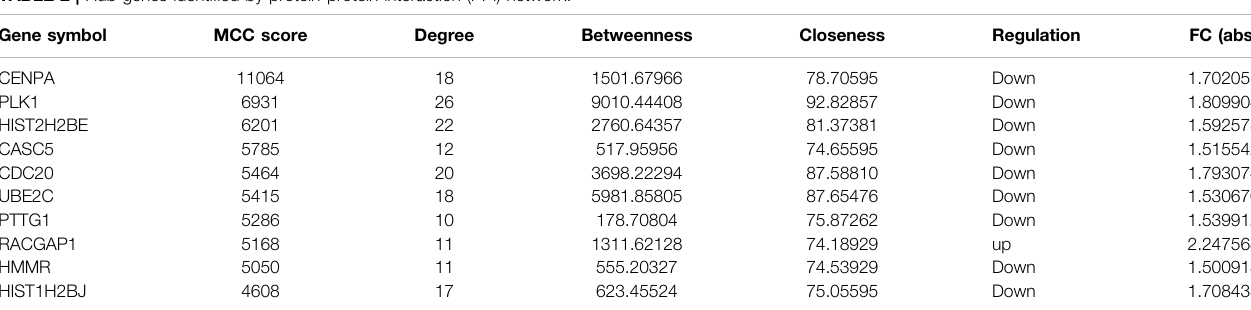
TABLE 2 | Hub genes identi fi ed by protein-protein interaction (PPI) network. Gene symbol MCC score Degree Betweenness Closeness Regulation FC (abs)